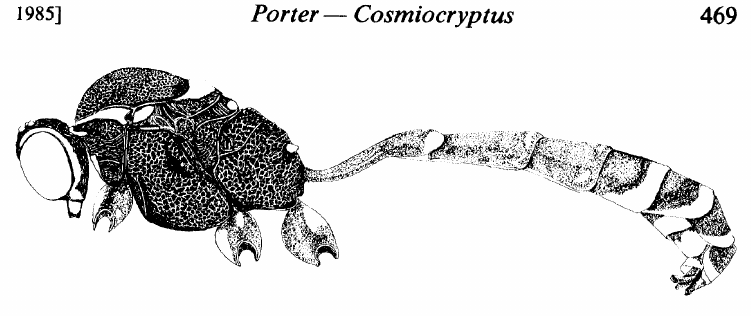
Fig. 1. Cosmiocryptus occidens, 6. Paratype. Lateral view of whole insect, show- ing color pattern and